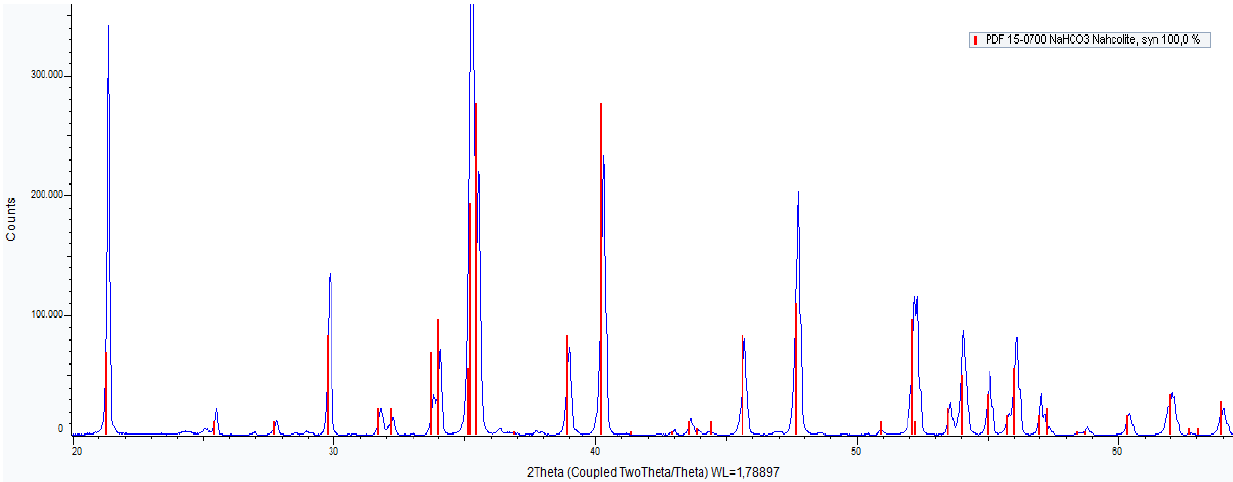
Figure B1. XRD quantitative analysis for crystals produced at 15 °C.